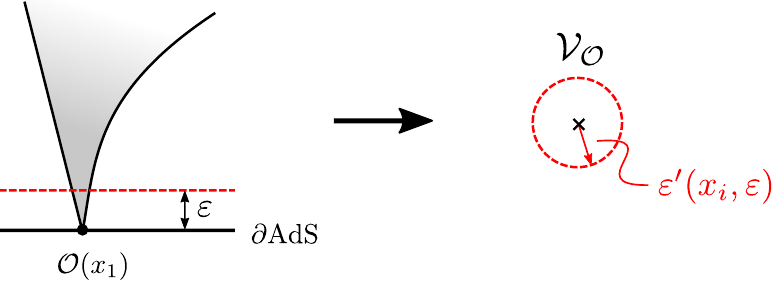
Figure 29 . The cut-o(cid:11) in AdS provides a cut-o(cid:11) on the worldsheet. However the relation between the two depends on the positions of operator insertions.